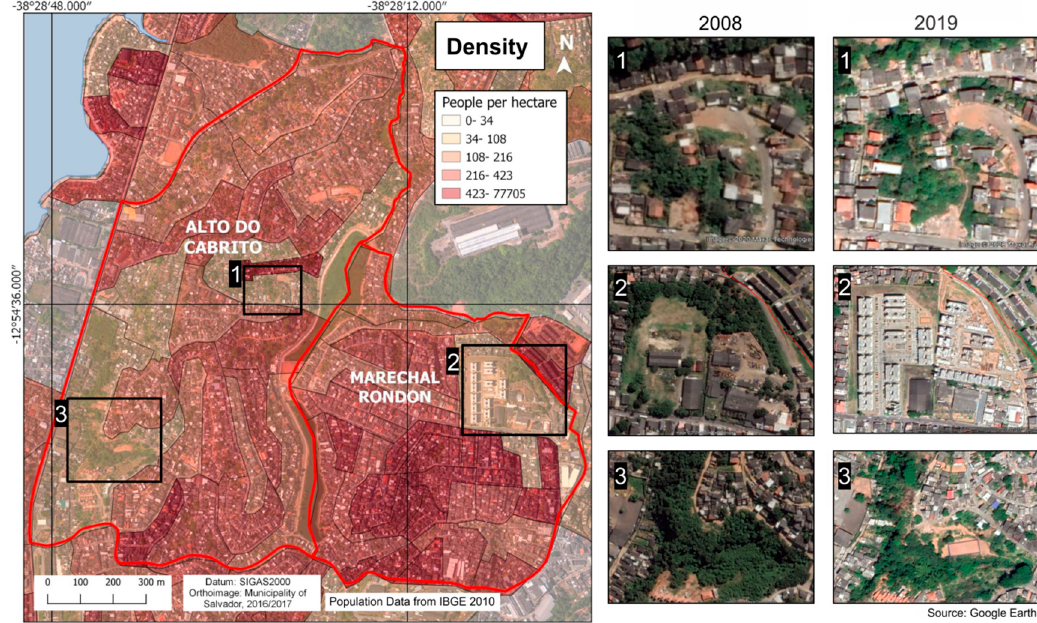
Figure 6. Alto do Cabrito and Marechal Rondon density in 2010 and urban growth.